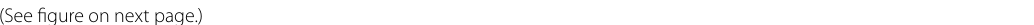
(See figure on next page.) Fig. 3 mDC-Exo promoted osteogenic differentiation of BM-MSCs by transferring miR-335. a Higher expression of miR-672, miR-335, miR-124, and miR-125a-5p in mouse mDC-Exo relative to imDC-Exo (GSE33179). *P < 0.05, vs. imDC-Exo. b Expression of miR-672, miR-335, miR-124, and miR-125a-5p determined by qRT-PCR analysis in imDC-Exo and mDC-Exo separated according to the method mentioned above. *P < 0.05, vs. imDC-Exo. c miR-335 expression determined by qRT-PCR analysis in mDC-Exo-NC and mDC-Exo-miR-335I. **P < 0.01, vs. mDC-Exo-NC. d ALP activities expressed in optical density (OD) values at 520 nm, e , f Runx2 mRNA and protein levels, and g miR-335 expression in BM-MSCs in the groups of control, induction, mDC-Exo, and mDC-Exo-NC, and mDC-Exo-miR-335I on the 7th day of culture. *P < 0.05, **P < 0.01, vs. Control; # P < 0.05, ## P < 0.01, vs. mDC-Exo-NC. h The exosomes isolated from Cy3 (red)-miR-335-transfected mDCs were labeled with the lipophilic fluorescent dye Dio (green) and incubated with BM-MSCs (nuclei stained with Hoechst 33,342, blue). The uptake of exosomes by BM-MSCs was observed by confocal laser microscopy. (I) ALP activities expressed in OD values at 520 nm, (J‑K) Runx2 mRNA and protein levels in BM-MSCs transfected with miR-335 mimics and mimic NC. **P < 0.01, vs. mimic